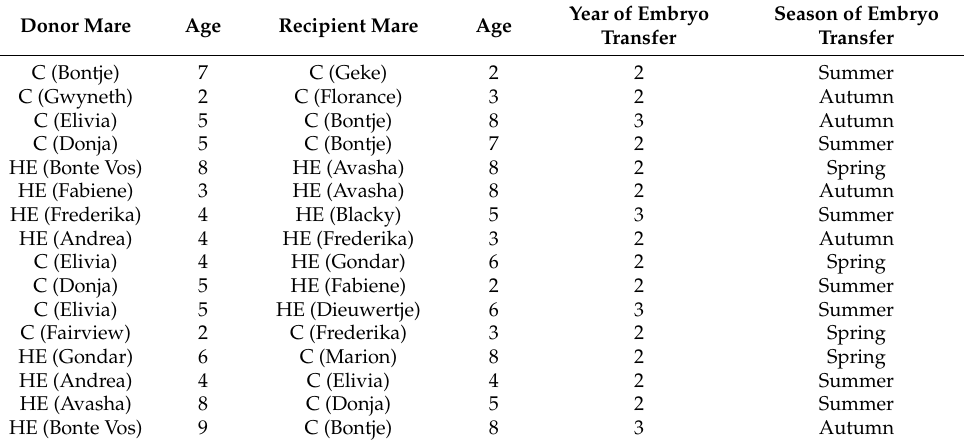
Table 1. Composition of the subgroups (C-C, C-HE, HE-C and HE-HE), including the names of the individual ponies, their age, and the year and season in which embryo transfer and conceptus recovery were performed.